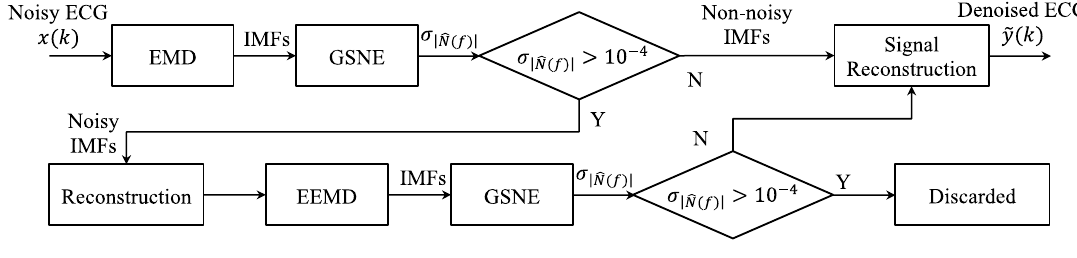
Figure 4. The flowchart of the proposed GSNC scheme.